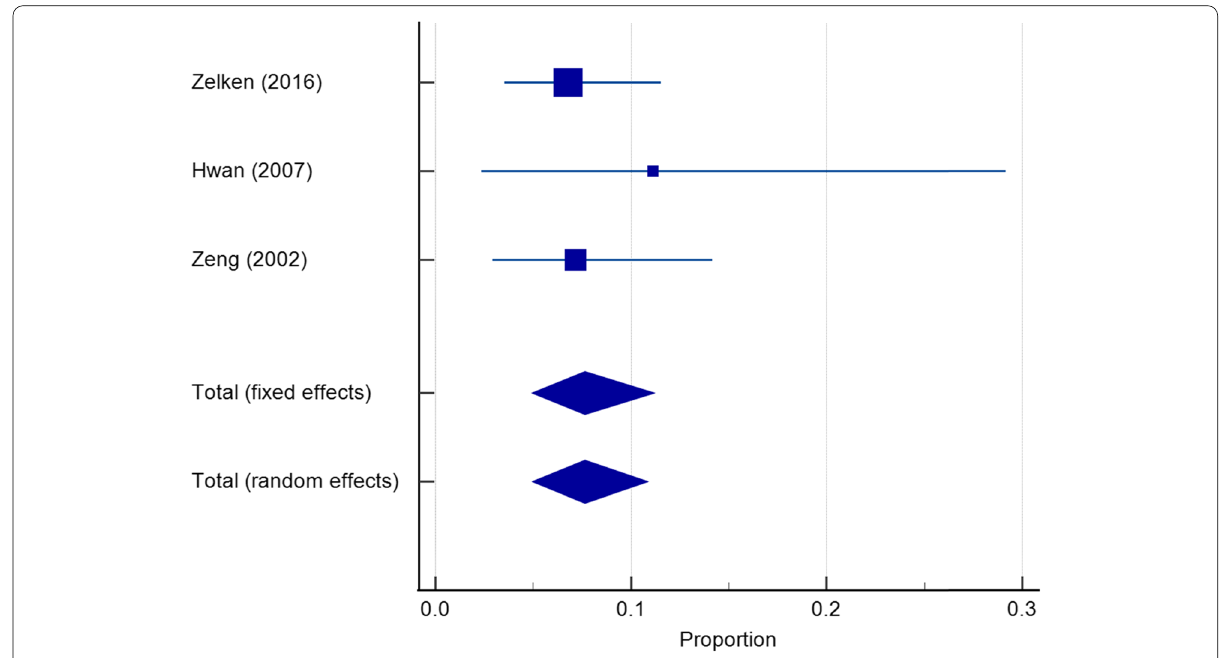
Fig. 11 Revision rates reported for silicone in both fixed and random-effects